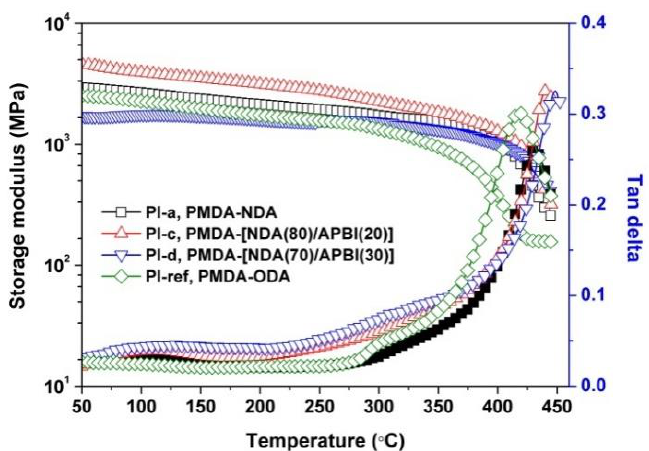
Figure 9. Dynamic mechanical analysis (DMA) curves of PI films.